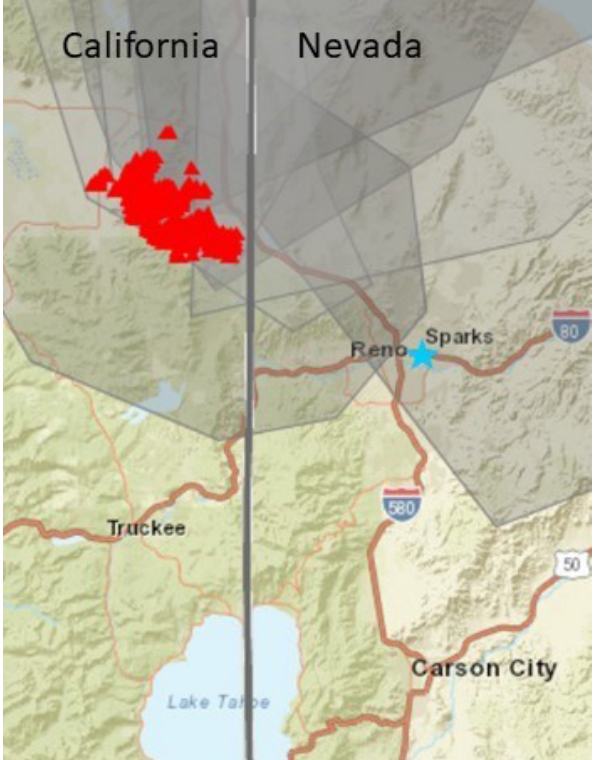
Figure 1. NOAA HMS smoke and fire location for 16 August 2020. The Loyalton fire is burning in California near the Nevada bor- der at this time. The blue star shows the location of the Sparks, NV, monitoring site, which is approximately 35–45km from the fire. This map was created from the AirNowTech site (https://www. airnowtech.org/, last access: 10 September 2022).